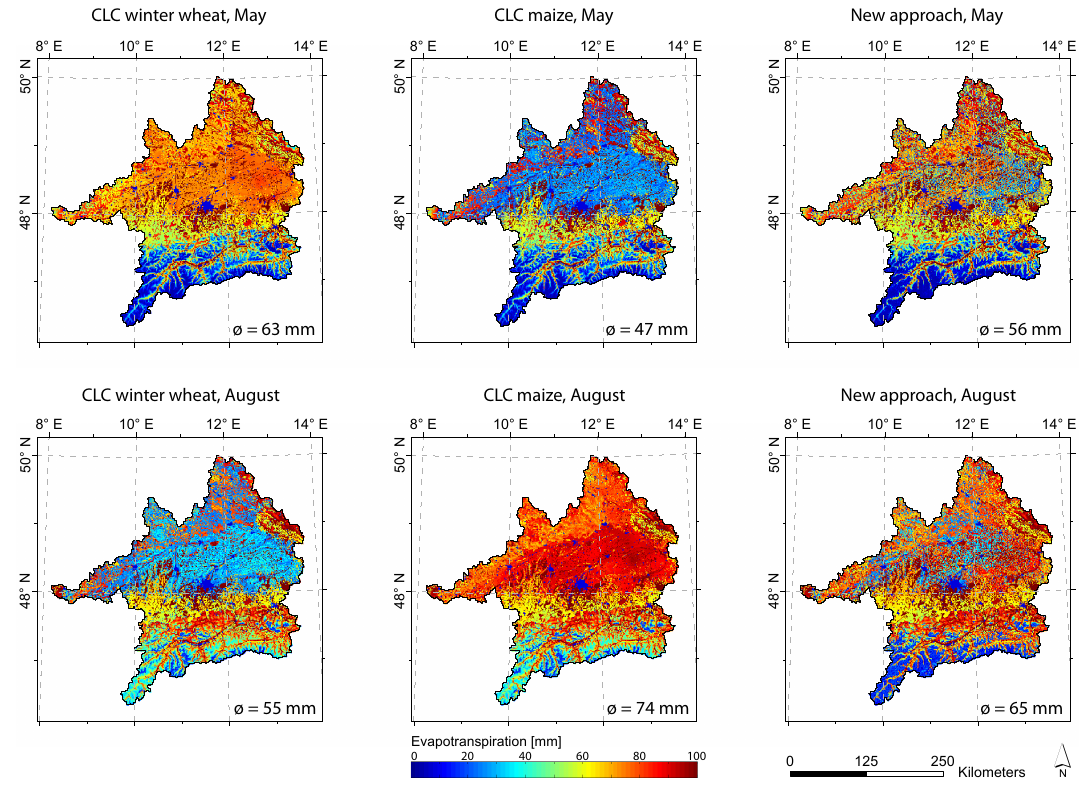
Fig. 8. Modelled mean monthly evapotranspiration (1971–2000) in May and August with three different land use/cover classification schemes implemented in PROMET (CLC winter wheat, CLC maize and the new land use/cover approach) for the Upper Danube